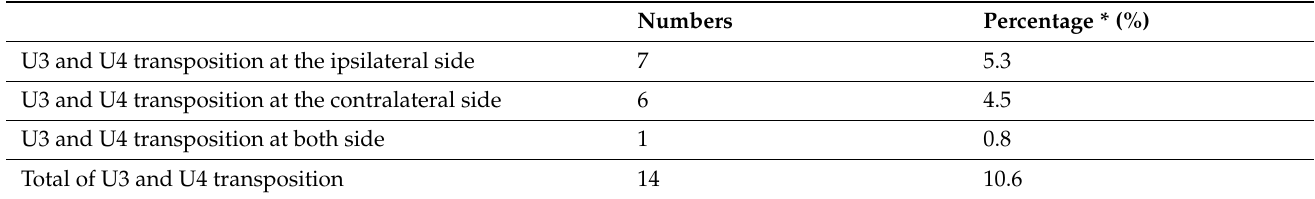
Table 6. Side distribution of transposition of upper canine and first premolar. (Patient with unilateral side of transposition is subdivided into ipsilateral or contralateral to the cleft